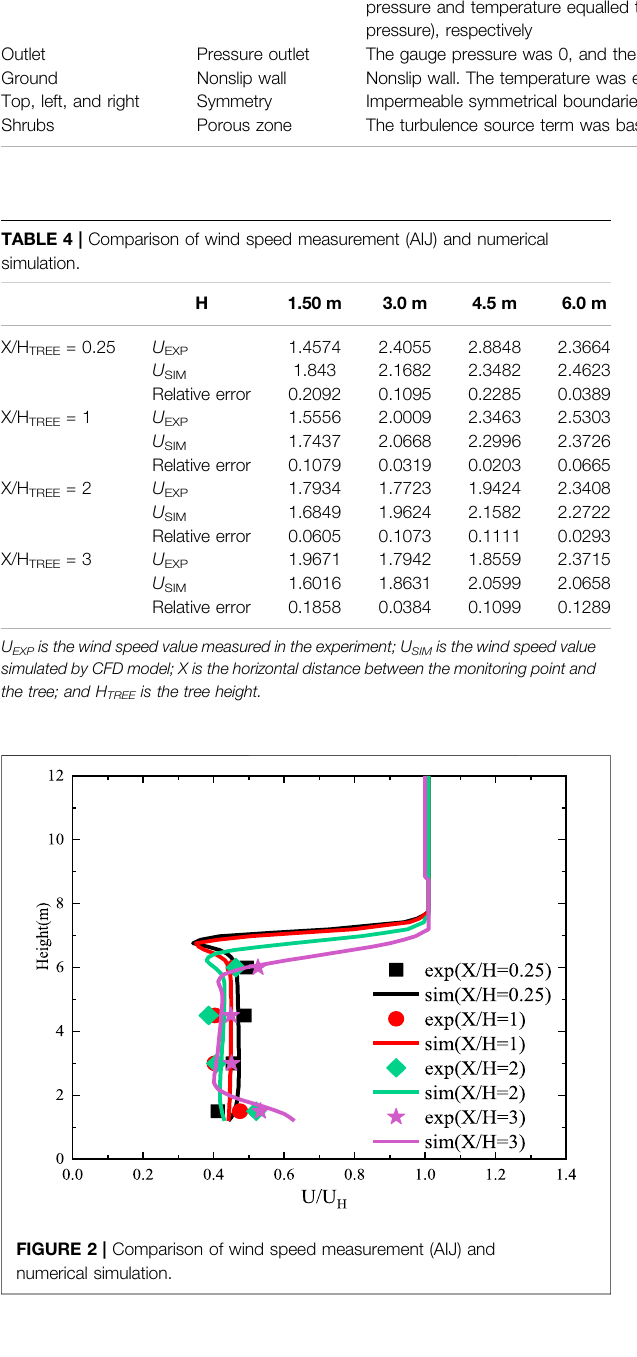
FIGURE 2 | Comparison of wind speed measurement (AIJ) and numerical